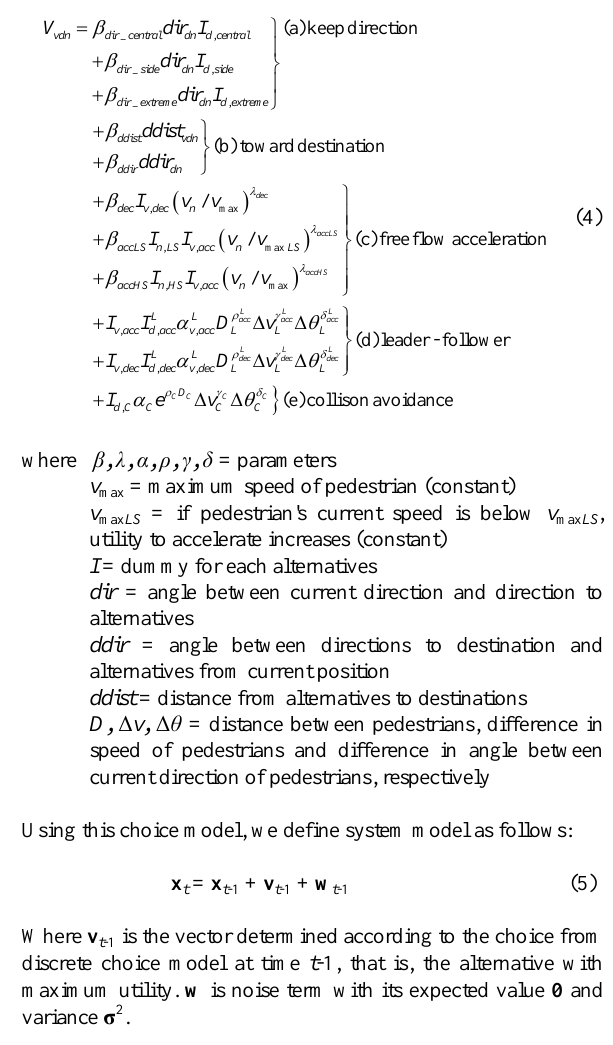
Acc. Const. Figure 4. Choice set from Robin et al. (2009)